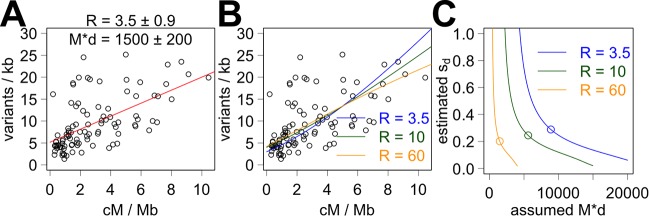
Fitting the correlation between the variant distribution and recombination rate without and with background selection.(A) Red line indicates the line of best fit using the mutation model alone. (B) Colored lines indicate the lines of best fit using combination of the mutation model with background selection and using three different presumed R coefficient values. (C) Colored lines indicate the estimates of sd coefficients, and circles indicate the sd estimate with the smallest p value. The circles in panel C indicate the values of sd and M*d used for the lines of best fit in panel B. The presumed value of U is 0.48, and the presumed value of the outcrossing rate is 1.7%.